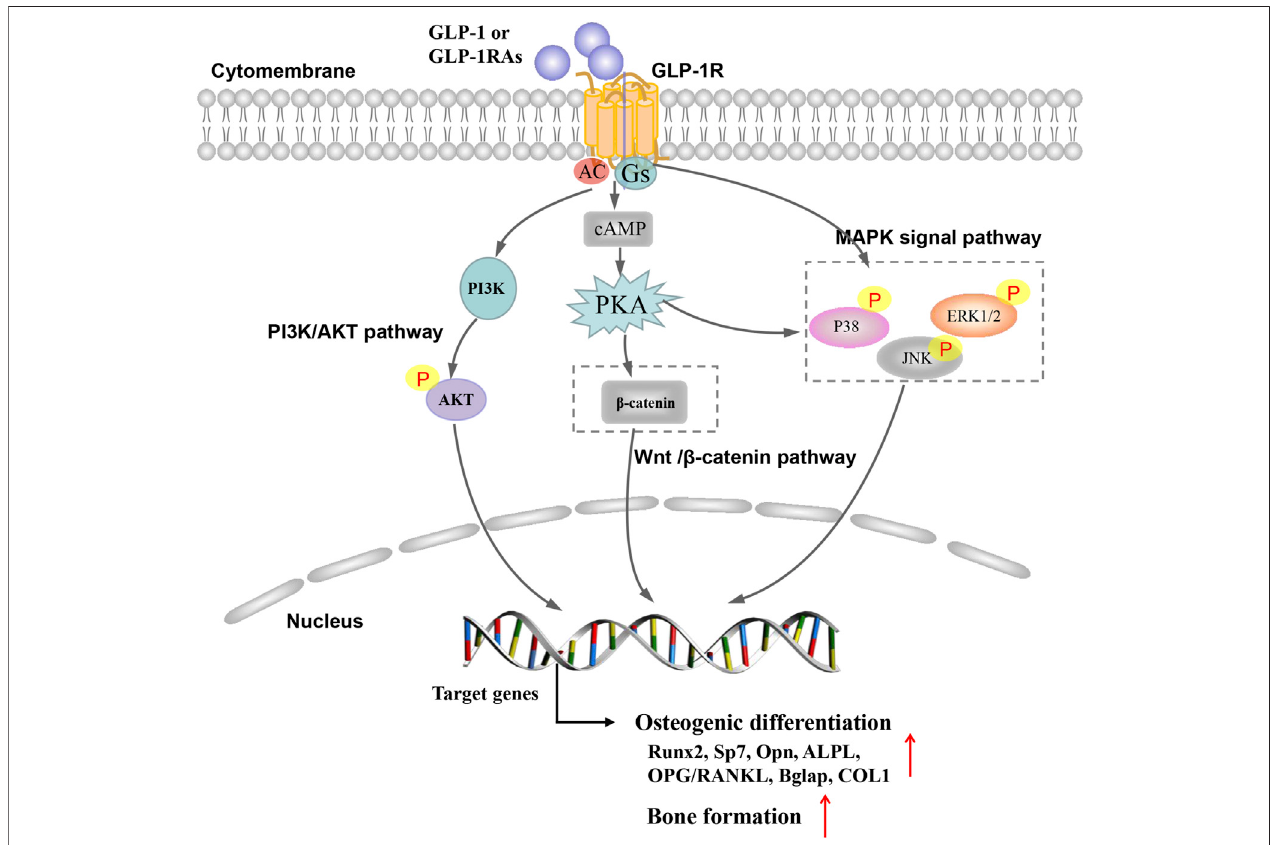
FIGURE 1 | Possible mechanism of glucagon-like peptide 1 receptor agonist on bone metabolism in osteoporosis.